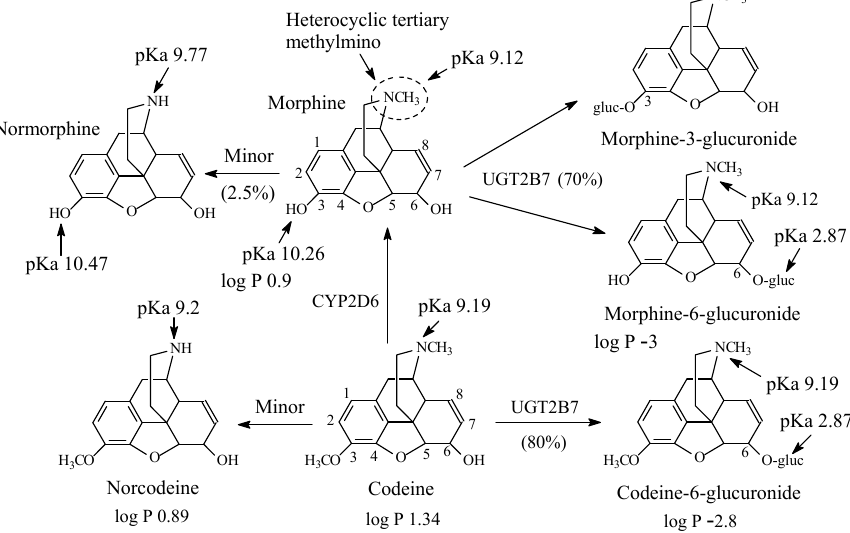
Figure 25. Metabolic pathways of codeine and morphine.